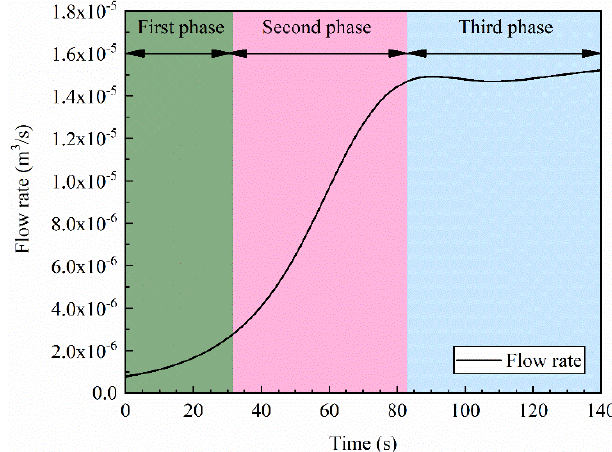
Figure 8. Flow rate curve.